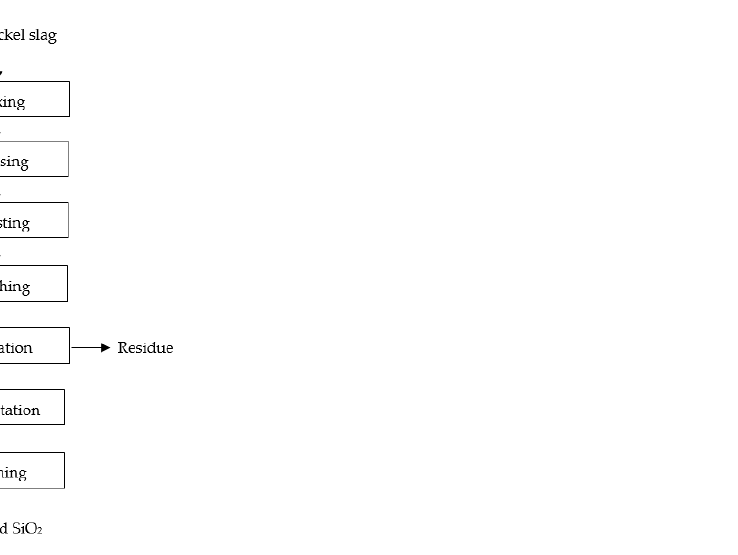
Figure 13. The flowchart of pyro-hydrometallurgy route to recover silica from Indonesian ferronickel slag.